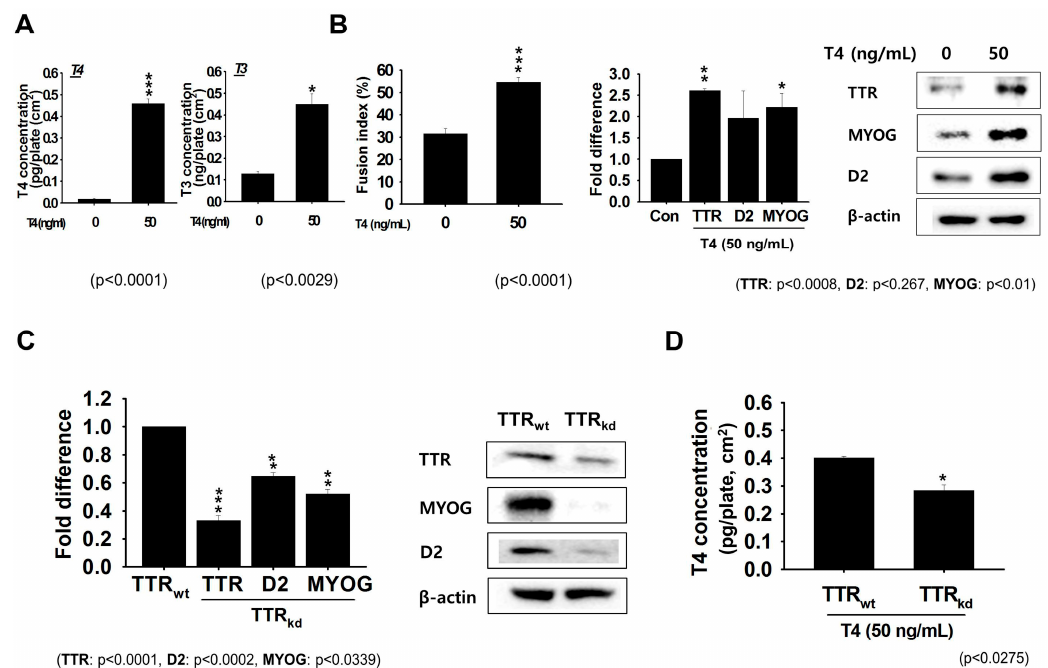
Figure 4. Estimation of T3 and free T4 concentrations with serum free media in C2C12 cells. C2C12 cells were incubated with serum free media for two days. ( A ) Difference in T3 and T4 concentrations in the presence or absence of T4 in serum free media; ( B ) Fusion indices determined on culture Day 2 with or without T4 supplementation. Expressions of TTR and MYOG as determined by RT-PCR and Western blot; ( C ) Differential expression of TTR, MYOG, and D2 in TTR kd cells by RT-PCR and Western blot; ( D ) Analysis of T4 concentrations in TTR kd and TTR wt cells in the presence of T4. p -Values indicate statistical significance (mean ± S.D., n = 3, *: p < 0.05, **: p < 0.001, ***: p < 0.0001).